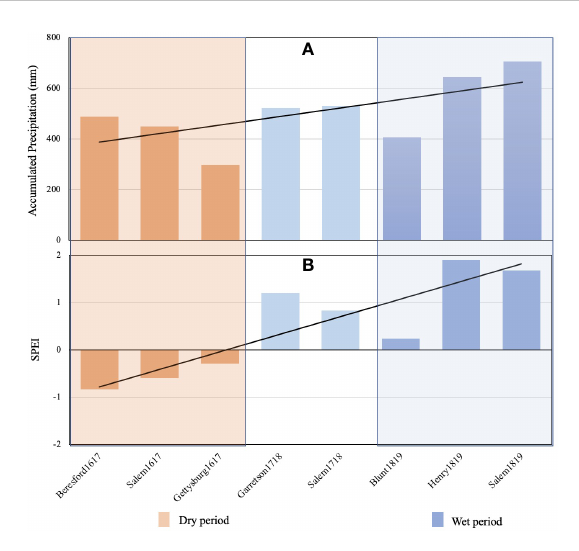
FIGURE 6 Trends of (A) accumulated precipitation (Oct-July), and (B) SPEI (in July) for the location-year combinations in South Dakota. 2016-17 and 2018-19 are indicated as dry and wet period respectively. Accumulated precipitation is in mm, SPEI is unitless. The black line indicates the linear